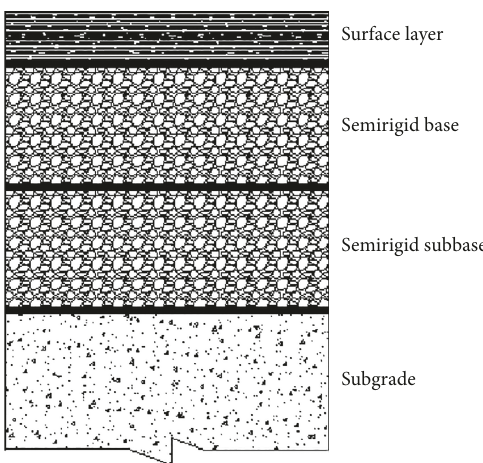
Figure 2: Typical semirigid asphalt pavement structure in China.